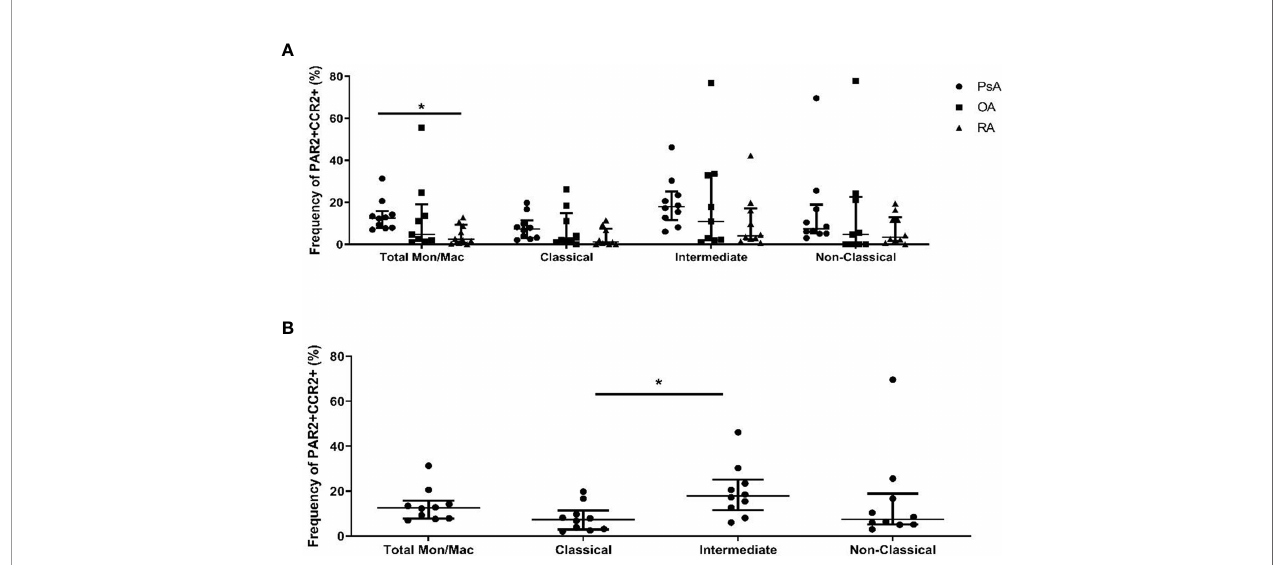
FIGURE 10 | PAR2+CCR2+ monocytes/macrophages are elevated in PsA SF cells. Flow cytometry was used to determine the frequency of PAR2+CCR2+ monocytes/ macrophages from SF of PsA, OA and RA patients ( A ; n=10 each). PsA patients had signi fi cantly higher total PAR2+CCR2+ monocytes/macrophages compared to RA patients (p=0.018). The proportion of total and subsets of monocytes/macrophages within PsA patients were compared in (B) . Intermediate (CD14 +CD16+) PAR2/ CCR2 expressing cells were higher than classical (CD14+CD16-) PAR2/CCR2 expressing cells in PsA patients (p=0.001). Error bars indicate median ± interquartile range. Asterisks are used to indicate signi fi cant differences between groups, where